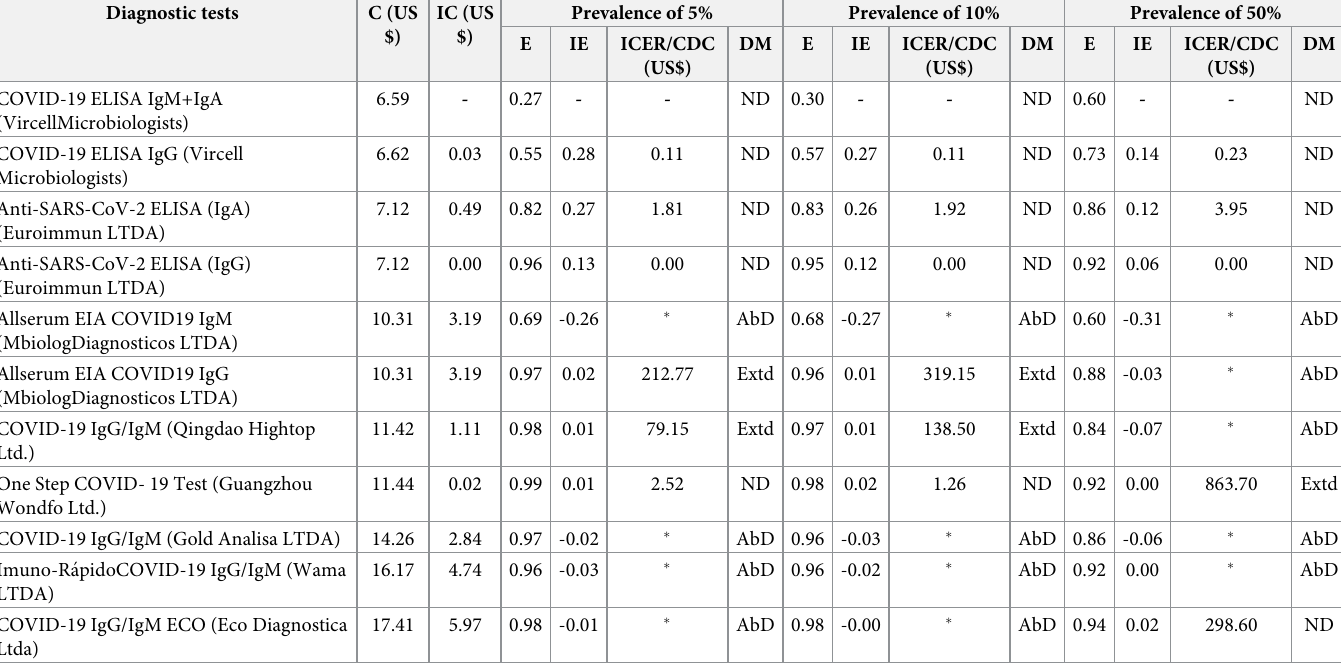
Table 5. Cost-effectiveness analysis including all tests for three hypothetical pretest probability scenarios (5%, 10%, and 50%). Diagnostic